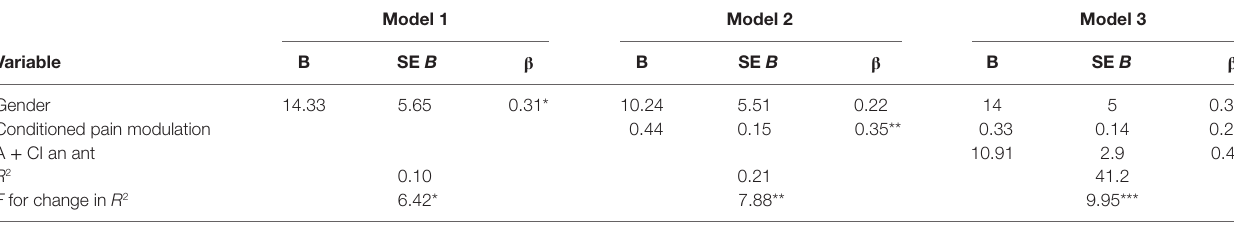
Table 3 | Hierarchical regression for predicting variables of pain decrease in an HCL